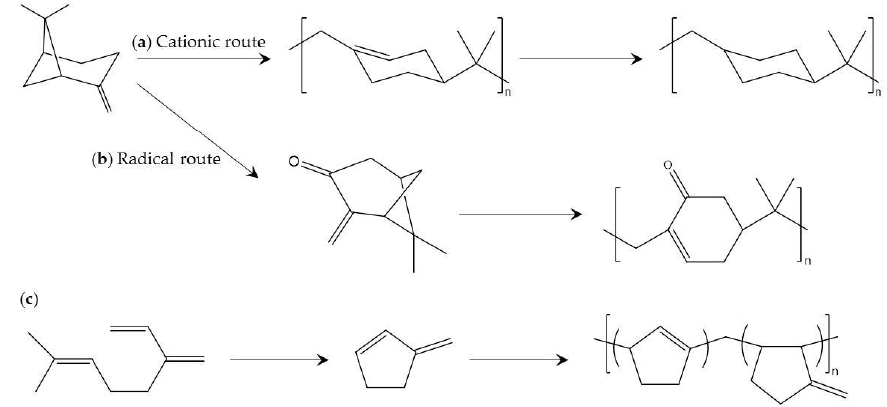
Figure 11. Production of polyterpenes from β -pinene using: ( a ) cationic polymerization [105]; and ( b ) radical polymerization [108]; and ( c ) production from myrcene [115].